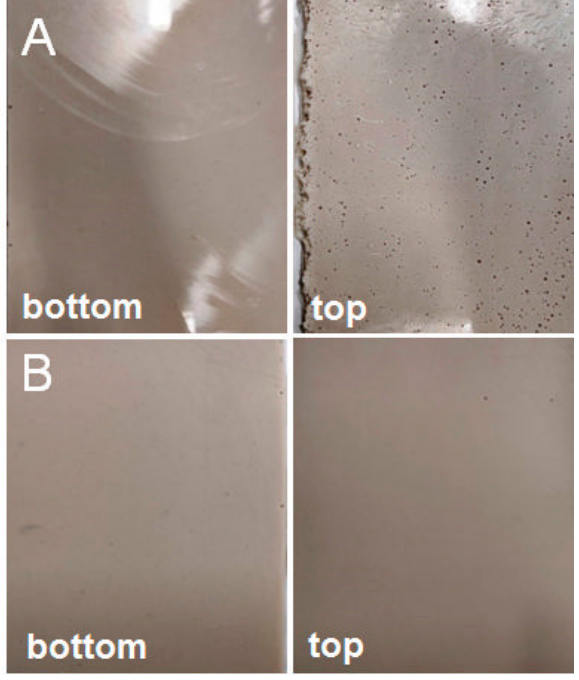
Figure 5. Panels cast in a glass mould, 70% of filling, ( A )—without degassing, ( B )—with degassing.